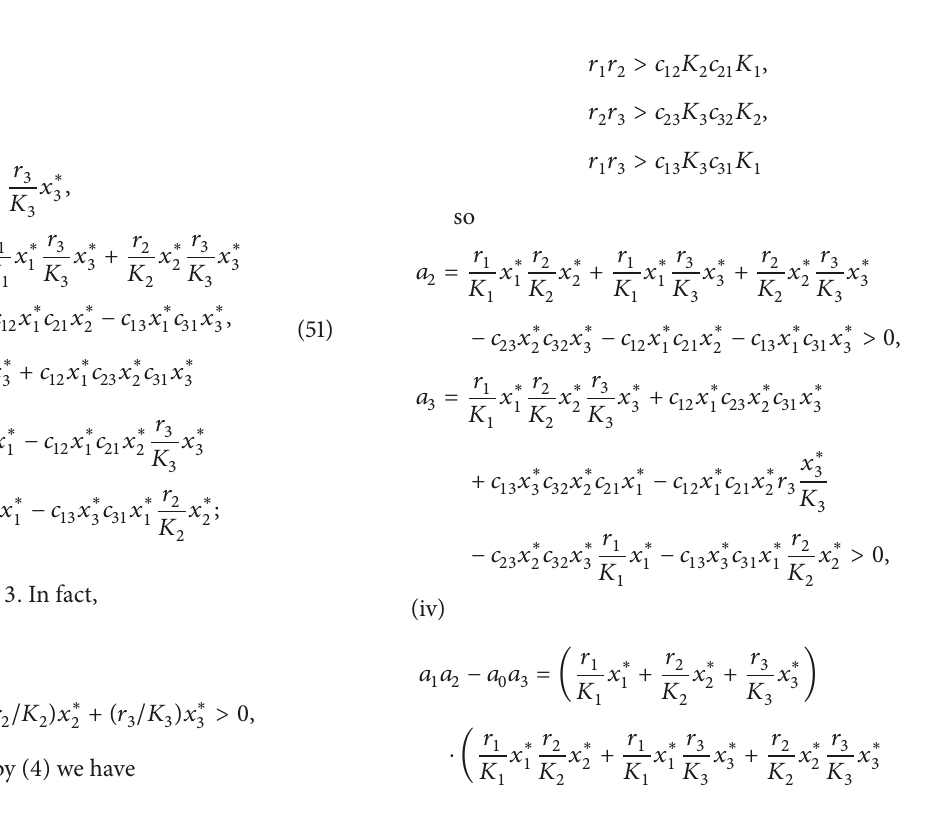
Figure 6: Dynamical behaviors and phase space trajectories of the three marine